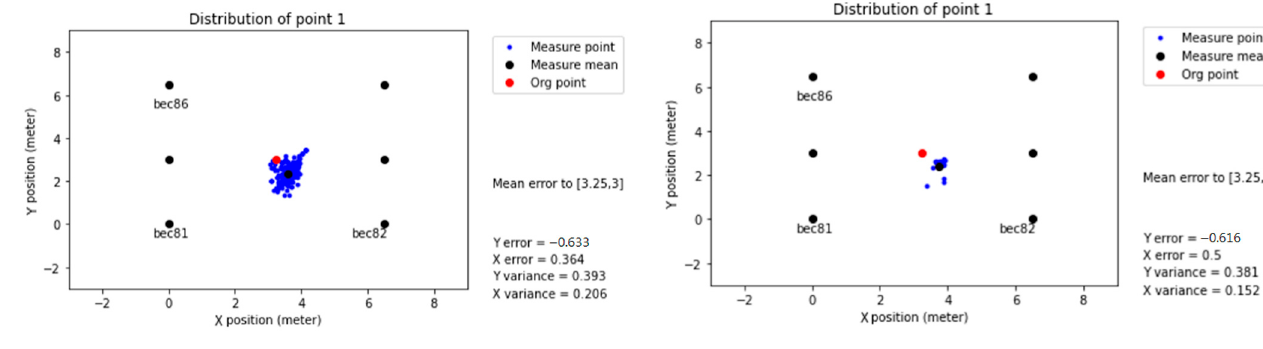
Figure 14. Comparison of the points section in the positioning accuracy.